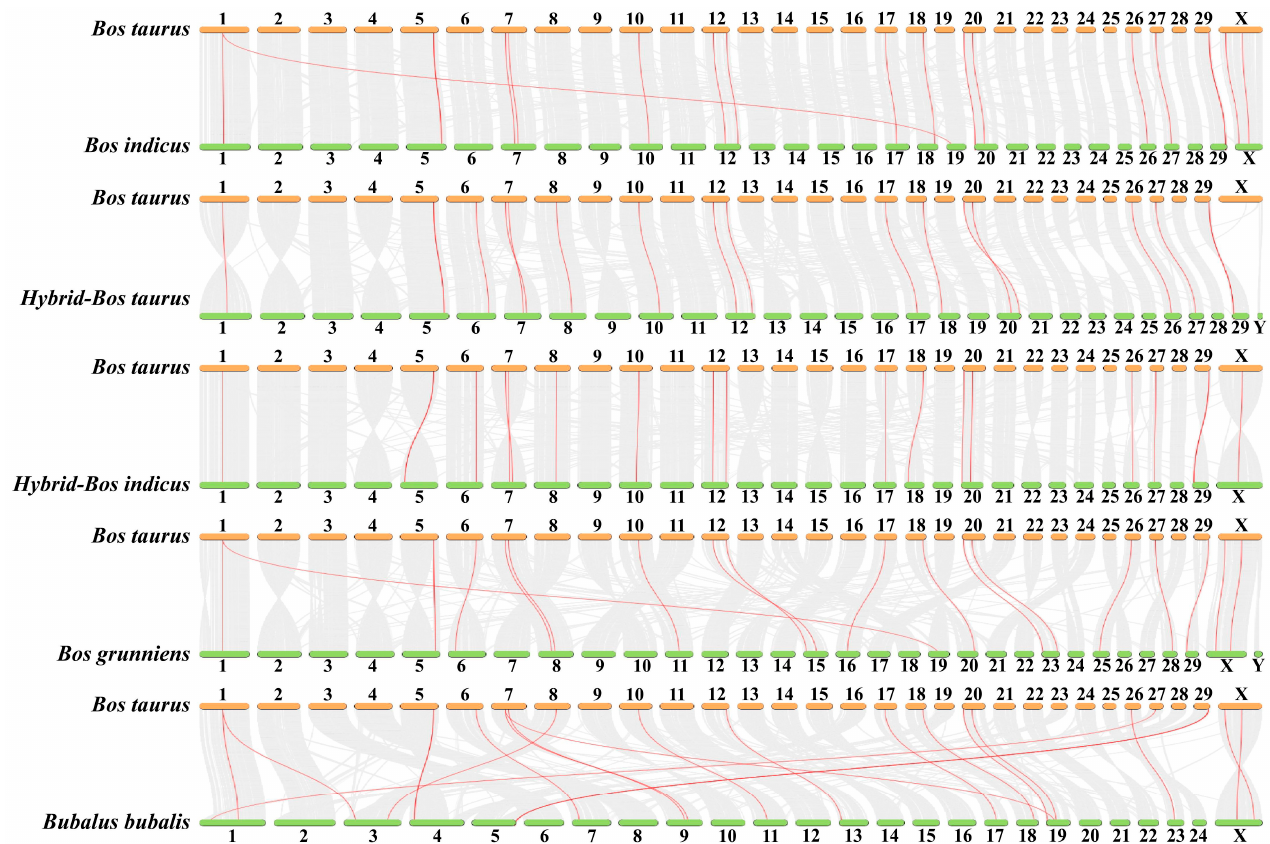
Figure 5. Collinear analysis of FGF gene. Table 2. Homology analysis of FGF gene between Bos taurus and other bovine subfamily species.